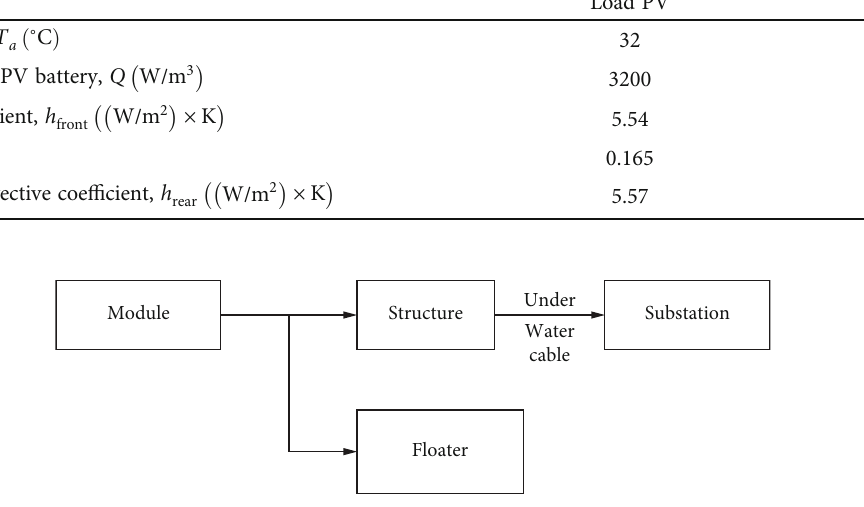
Figure 5: Flow diagram of the fl oating PV